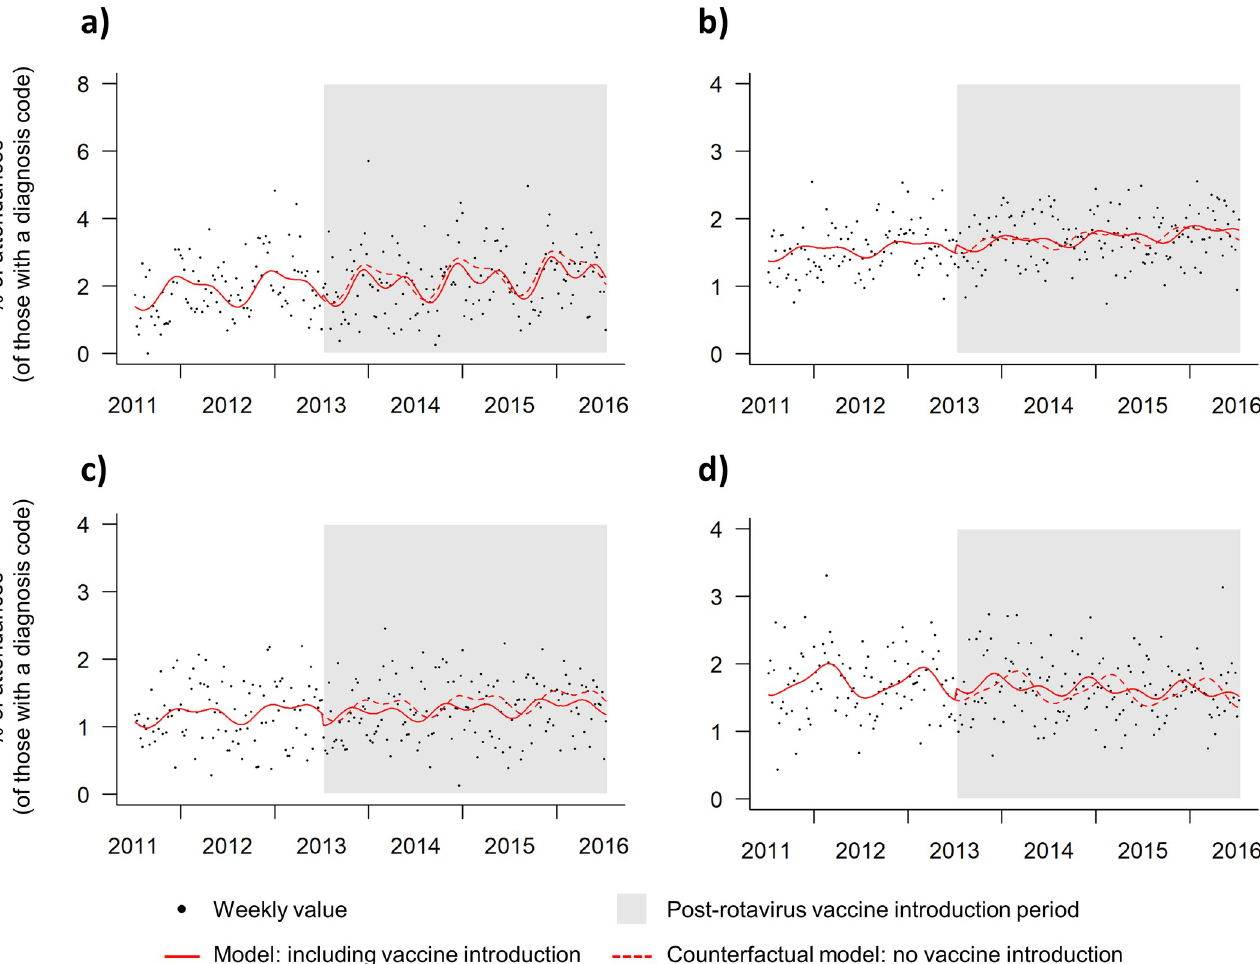
Fig 3. Weekly emergency department (ED) gastroenteritis visits, interrupted time-series regression model with level change and harmonic adjustment for seasonality, a) older children (5–14 years) and adults, b) 15–44 years, c) 45–64 years and d) 65+ years, week 27 2011 to week 26 2016 (grey box represents the rotavirus vaccine